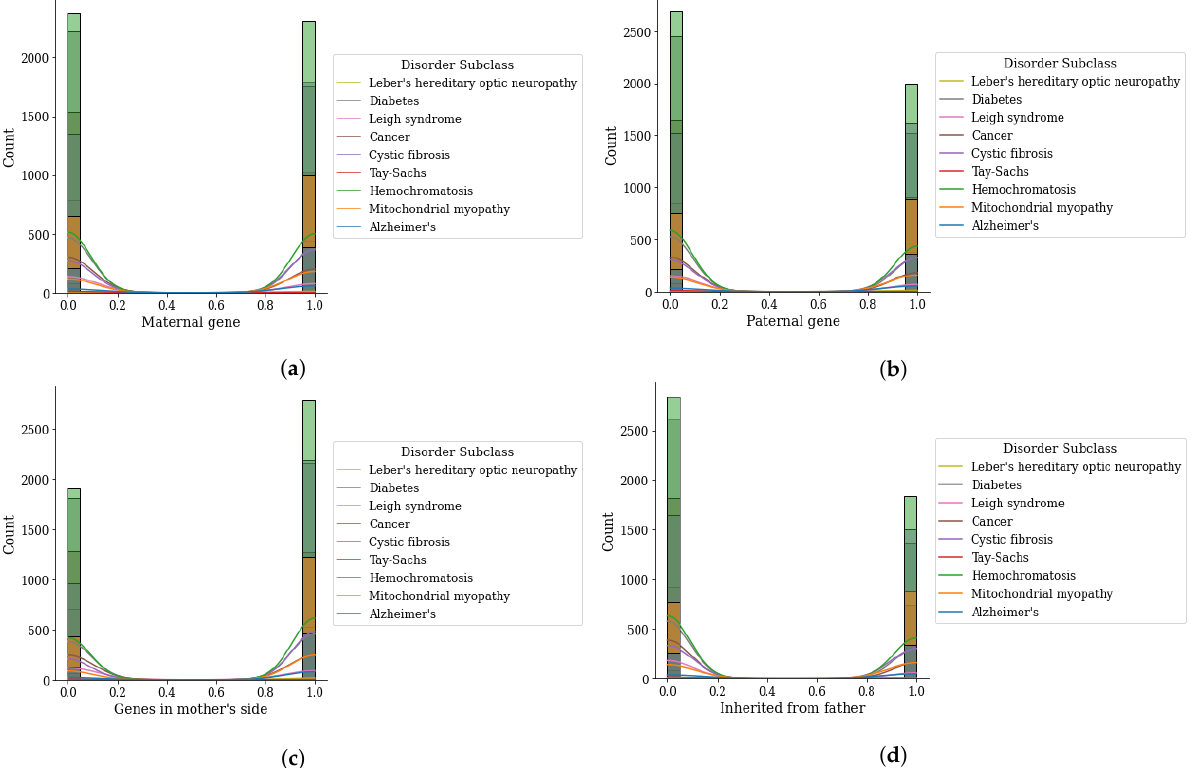
Figure 5. Genomes data distribution by genetic disorder sub-category, ( a ) maternal gene, ( b ) paternal gene, ( c ) genes from mother side, and ( d ) inherited from